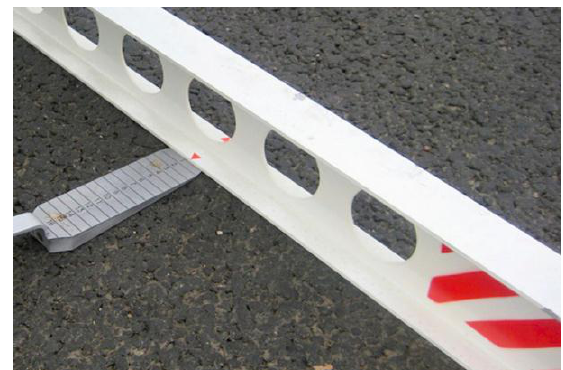
Figure 1. Measuring road surface parameters with level bar and wedge